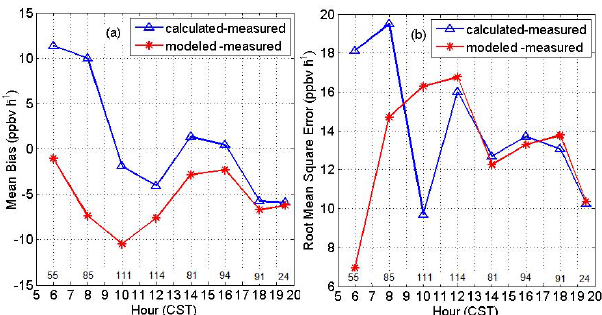
Fig. 4. (a) Mean Bias Error (MBE) and (b) Root Mean Square Error (RMSE) for calculated vs. measured data (blue line and open triangles) and for modeled vs. measured data (red line and stars) binned by hour of the day. The number of binned pairs of data is indicated on top of the x-axis